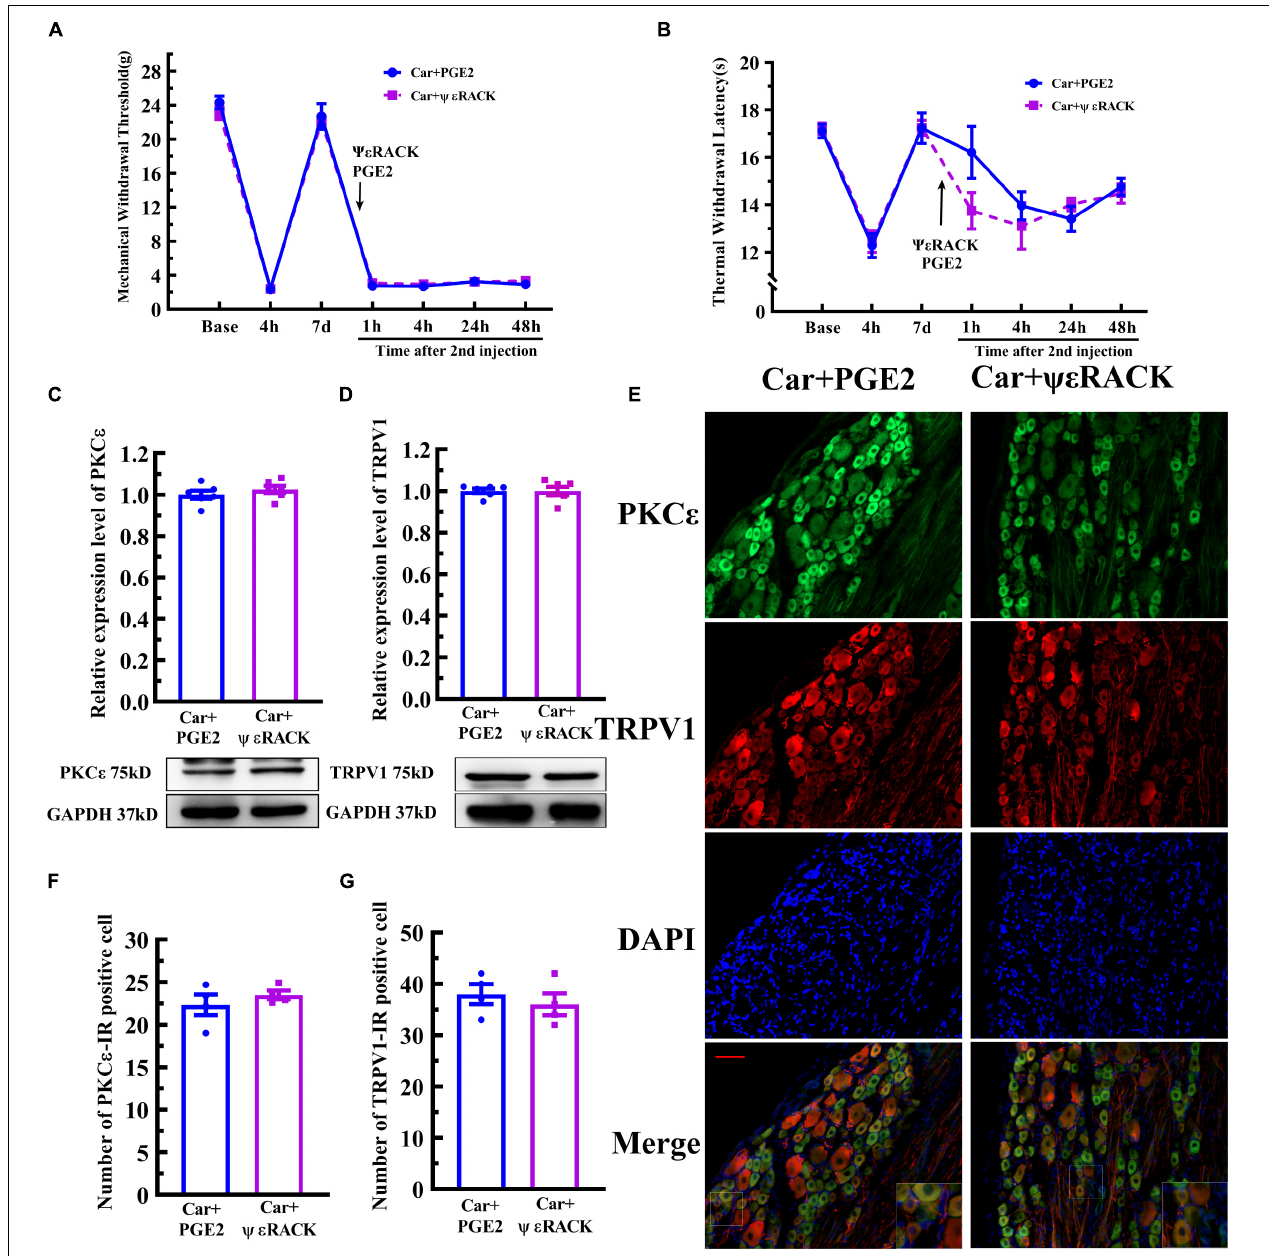
FIGURE 5 | Activation of PKC ε contributes to the transition from acute to chronic pain and TRPV1 expression. Mechanical (A) and thermal (B) responses of animals to the injection of a special PKC ε activator. n = 6. The quantification of the Western blot results and a representative Western blot showing PKC ε (C) and TRPV1 (D) protein isolated from the DRG 48 h after PGE2 and ψε RACK injection. (E) PKC ε and TRPV1 staining in the peripheral nervous system 48 h after PGE2 and ψε RACK injection. Scale bar 100 µ m. The quantification of PKC ε –IR positive (F) and TRPV1–IR positive (G)